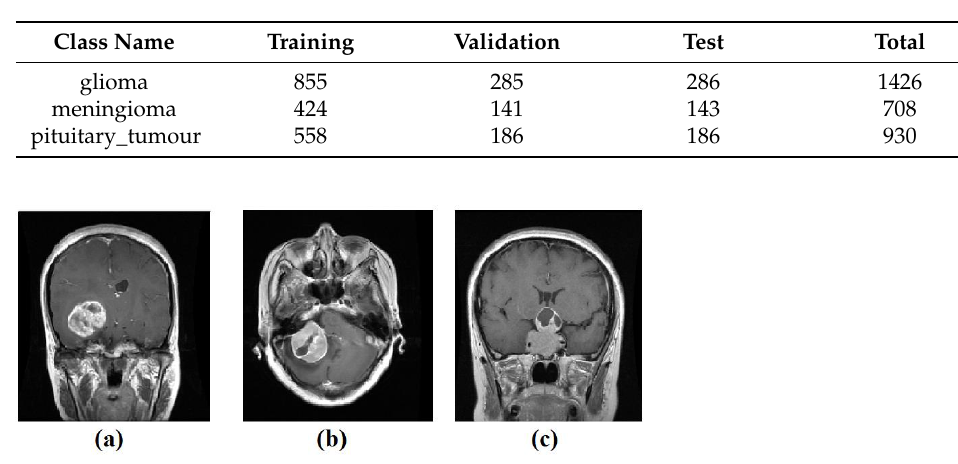
Figure 3. Example images from Brain tumour test set: ( a ) glioma, ( b ) meningioma, ( c ) pituitary tumour.